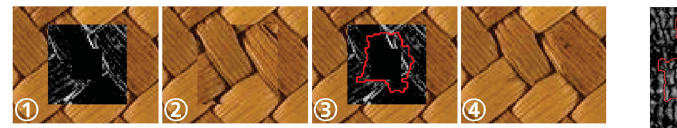
Fig. 7 Boundary cut used to draw a filled polygon defining the weight of the patch content to smooth the transition using Gaussian